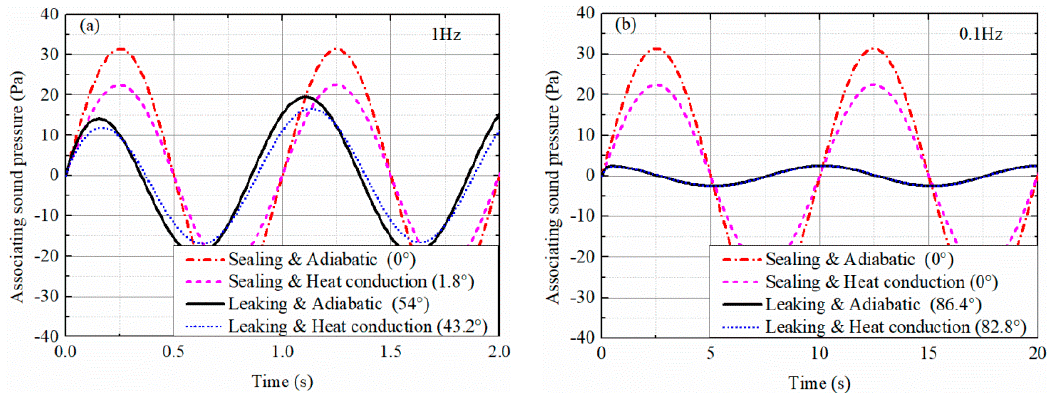
Figure 10. ( a ) Sound pressure waveforms of the associated sound pressure at 1 Hz. ( b ) Sound pressure waveforms of the associated sound pressure at 0.1